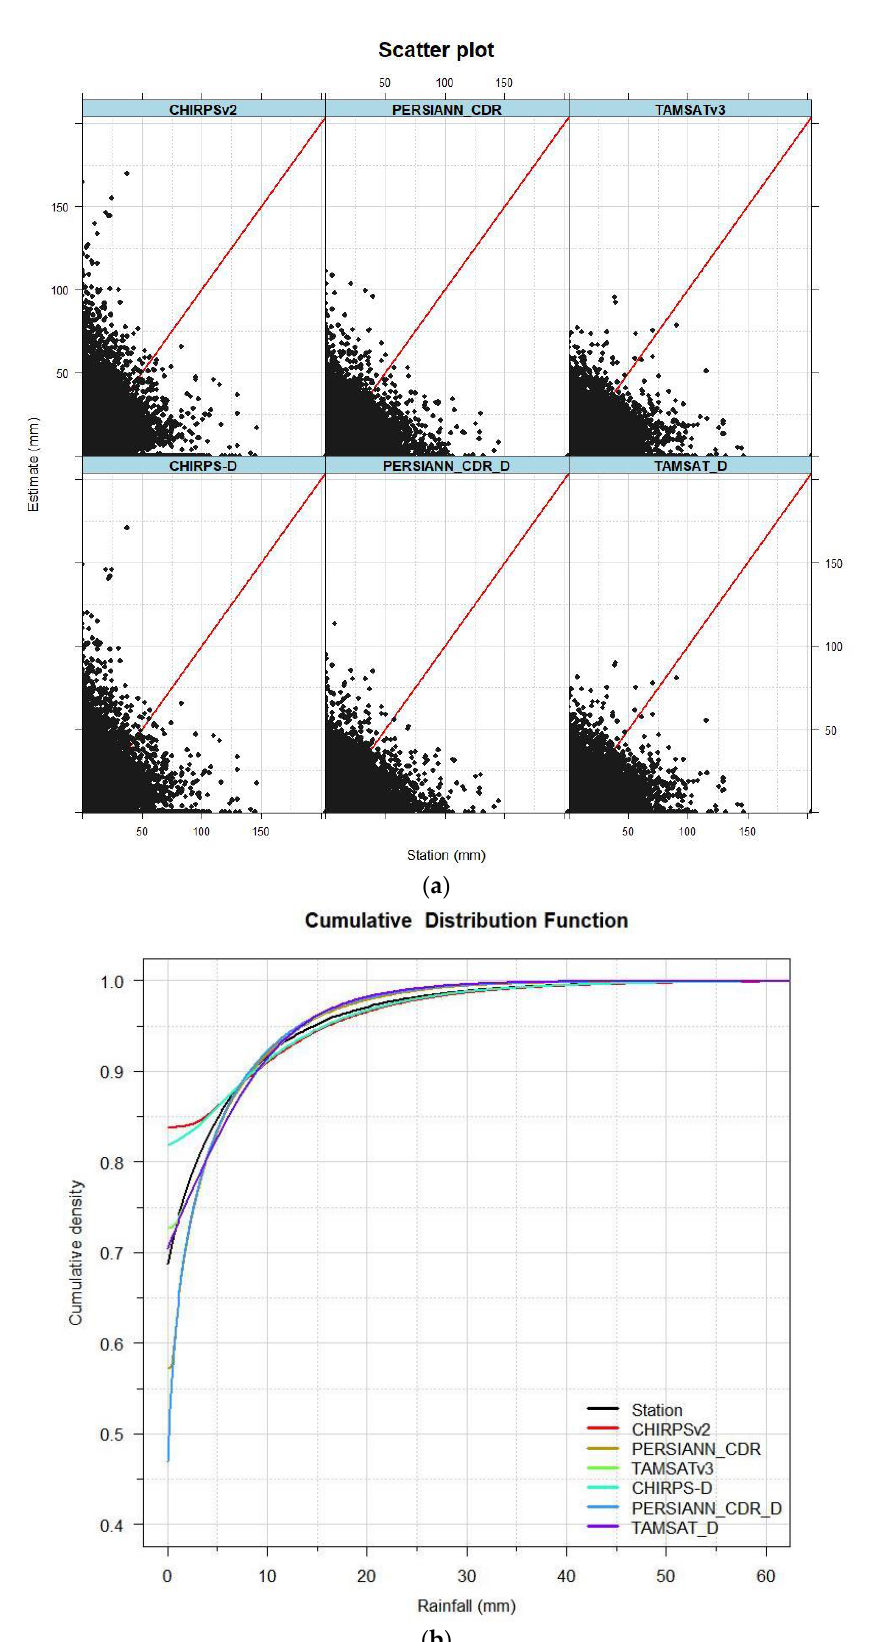
Figure 5. ( a ) Scatter plot of cumulative distribution function; ( b ) plots of observed rainfall against the global precipitation products .